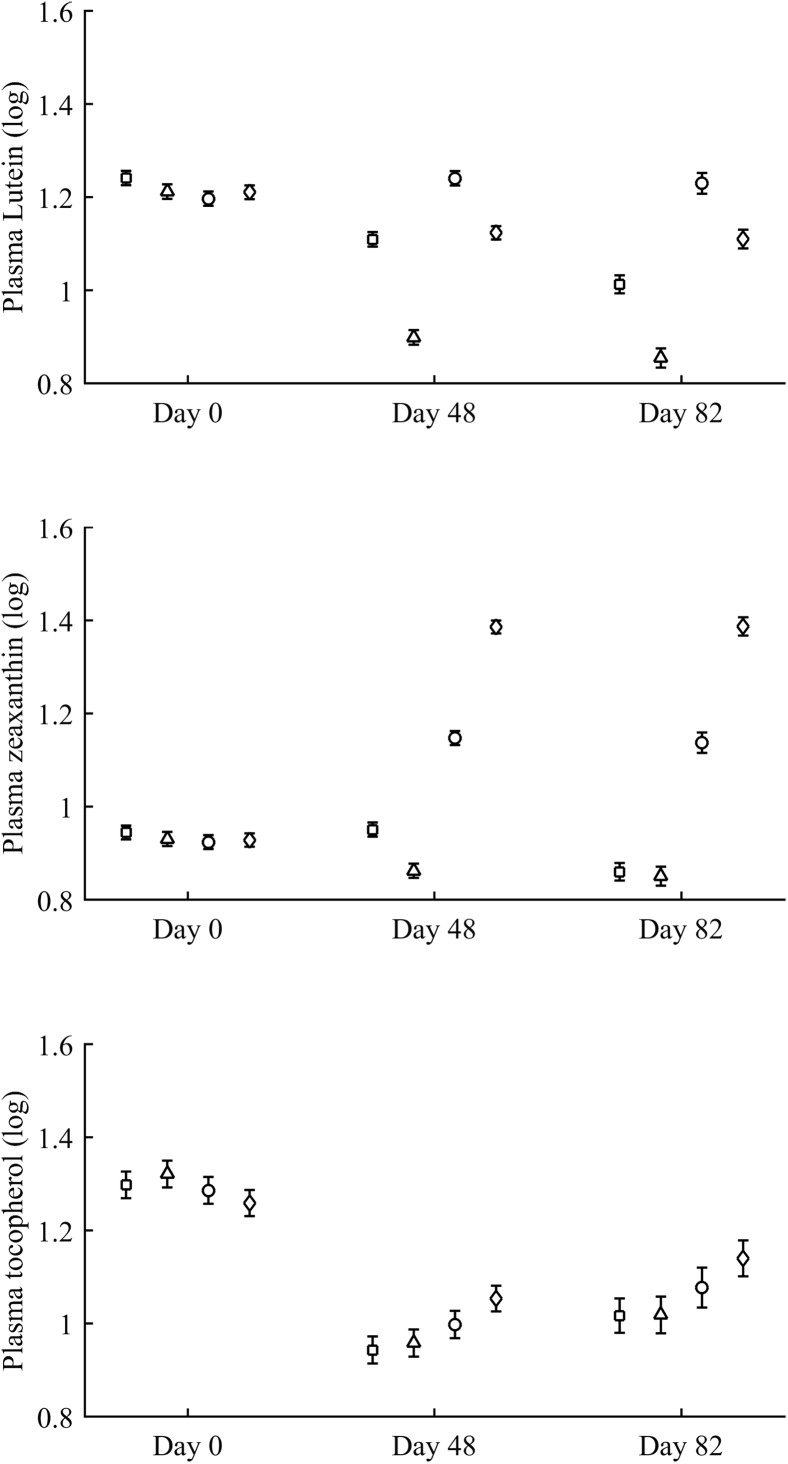
Changes in plasma carotenoid and tocopherol (log-transformed) levels during the experiment depending on the carotenoid treatment.Least square means � SE from the models (see Methods and Table 2). Squares: Control; Triangles: Astaxanthin; Circles: LutZea; Diamonds: ZeaLut.